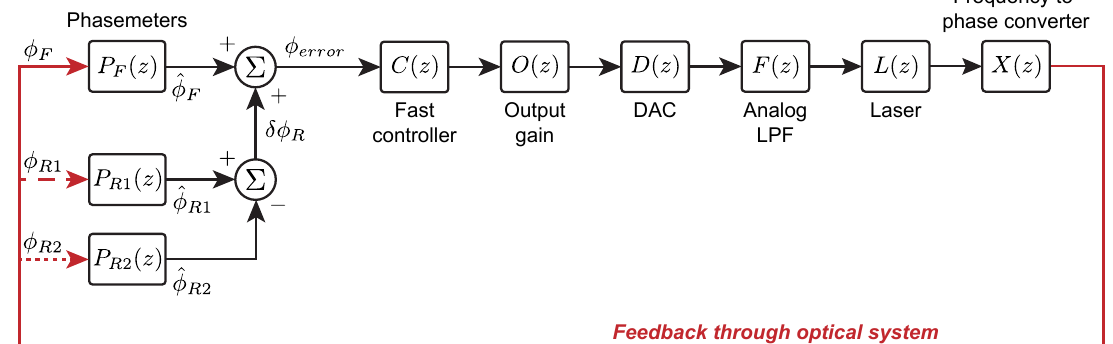
Figure 8. Linear transfer function model of the offset phase-locked OPA’s control system.